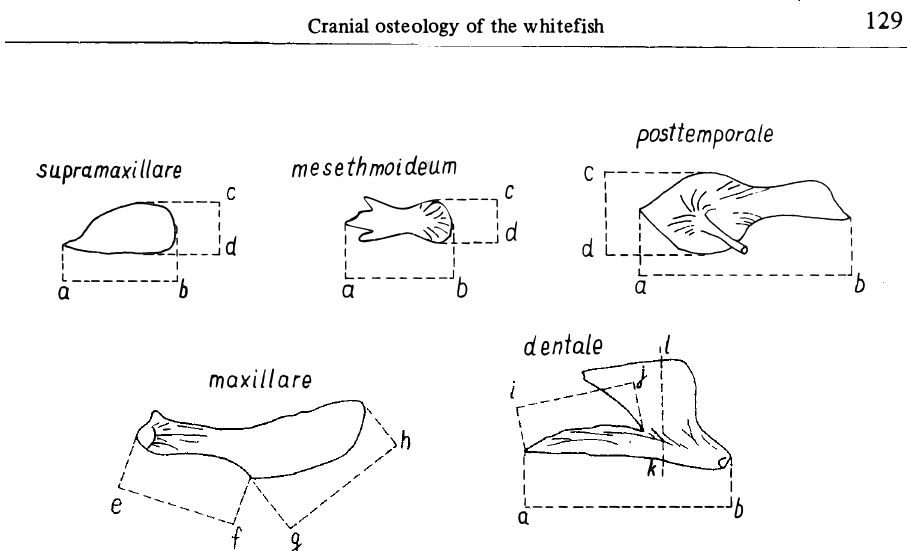
Fig. 5. Diagram of measurements on selected